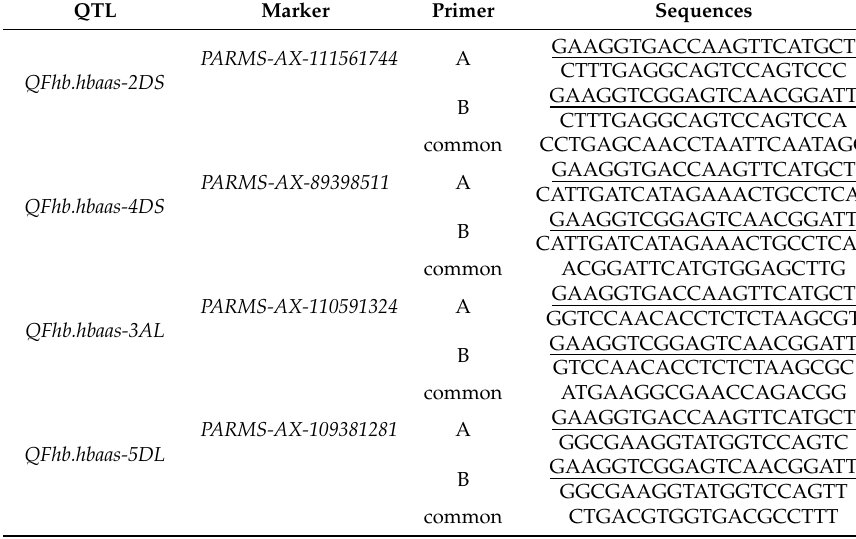
Table 8. Primers for penta-primer amplification refractory mutation system (PARMS)